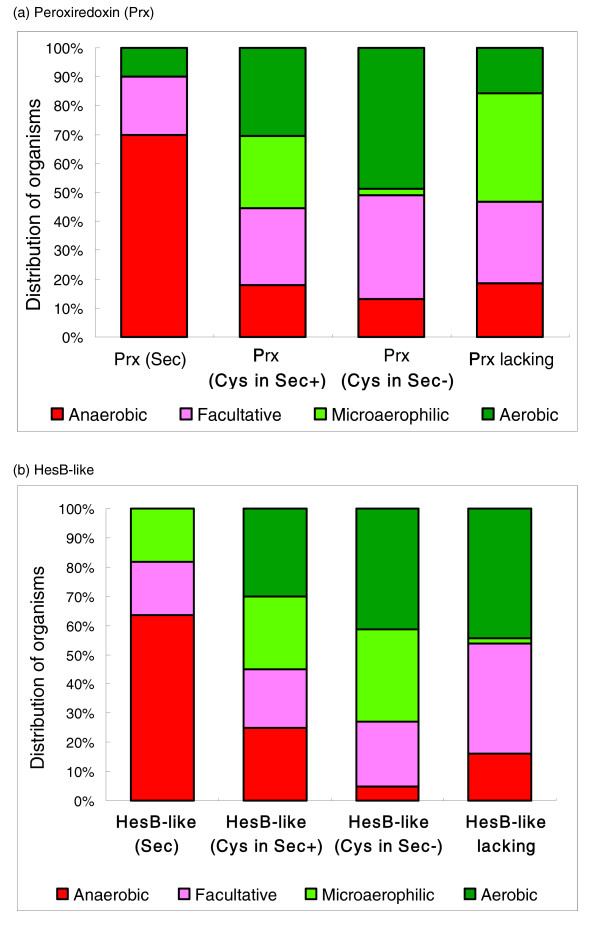
Relationships between two representative bacterial selenoprotein families and oxygen requirement of organisms containing these proteins. Organisms containing a member of a specific selenoprotein family (either Sec or Cys forms) were divided into four groups based on occurrence of the following: selenoproteins, Cys-containing homologs and the Sec trait, Cys-containing homologs and no Sec trait, and no representatives of this family. Distribution of organisms living under different oxygen conditions in each group is shown. (a) Peroxiredoxin (Prx). Peroxiredoxin homologs were identified by BLAST searches and included those containing the T/SxxU/C active site. (b) HesB-like protein. Sec+, organisms possessing the Sec-decoding trait; Sec-, organisms lacking the Sec-decoding trait.